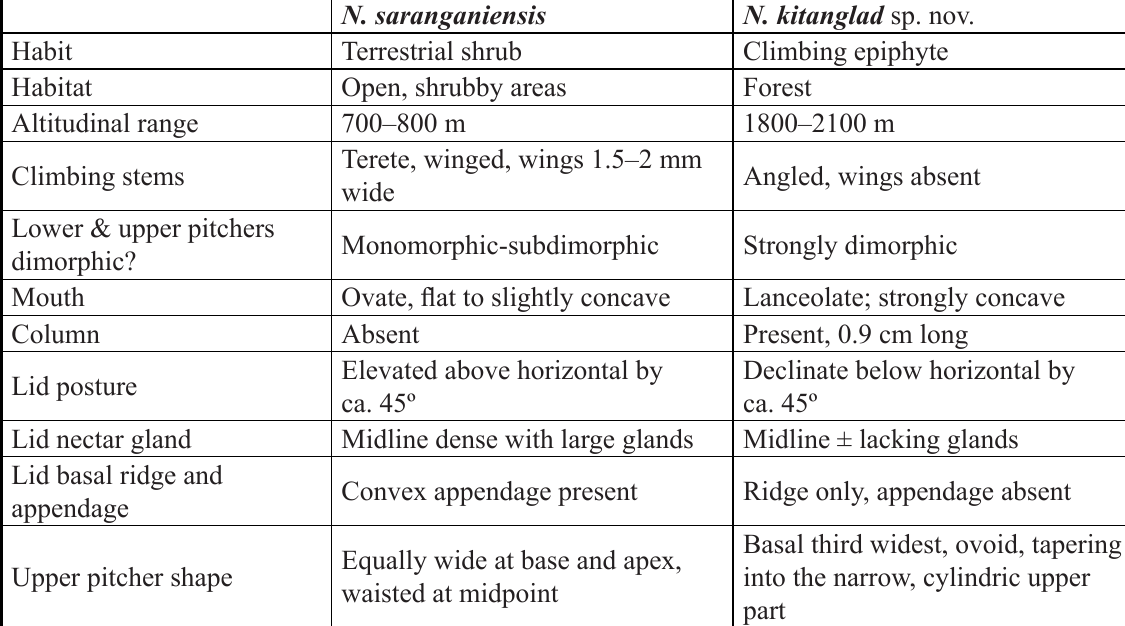
Table 2. Diagnostic characters separating N. saranganiensis and N. kitanglad sp.